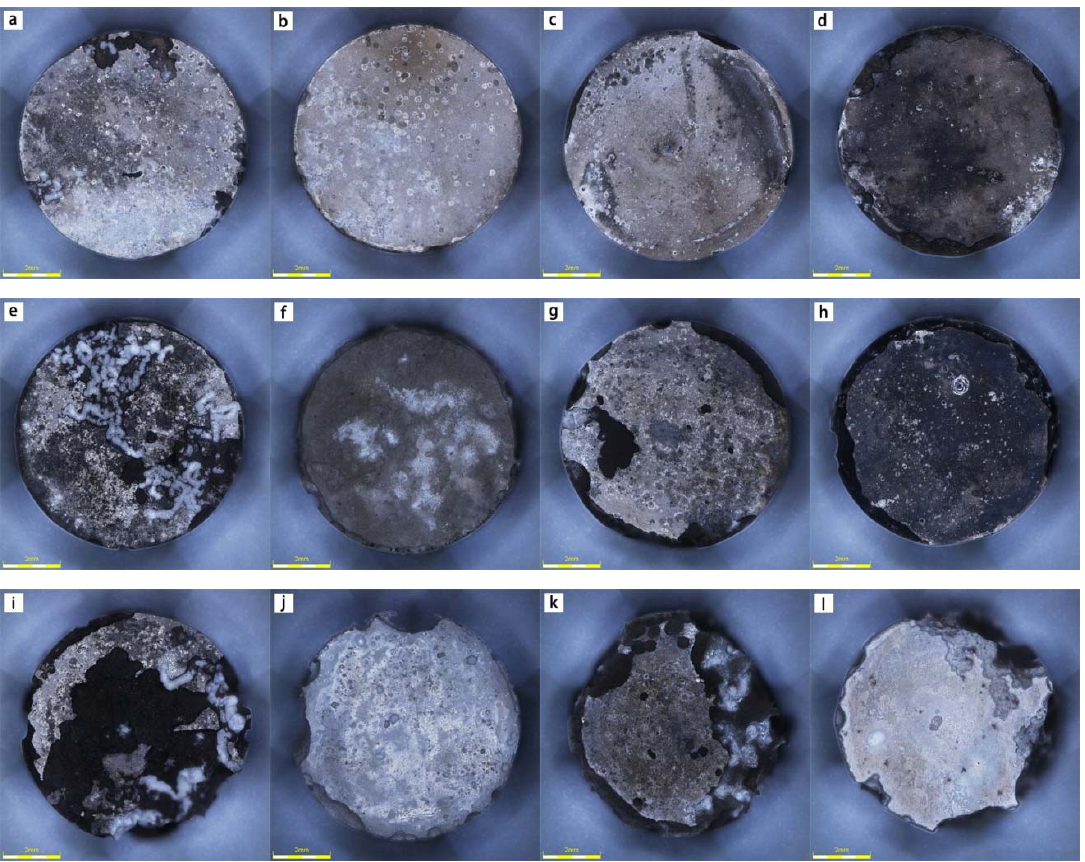
Figure 10. The macroscopic images after removing the corrosion product of the as-extruded ZX30 ( a , e , i ), ZK30 ( b , f , j ), ZKJ300 ( c , g , k ), ZKXQ3000 ( d , h , l ) alloys immersing for 1 d ( a – d ), 5 d ( e – f ) and 15 d ( i – l ).